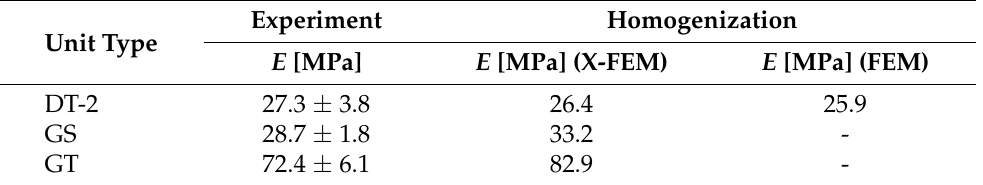
Table 9. Effective elastic properties of structures in Figure 17 from measurements and homogenization.